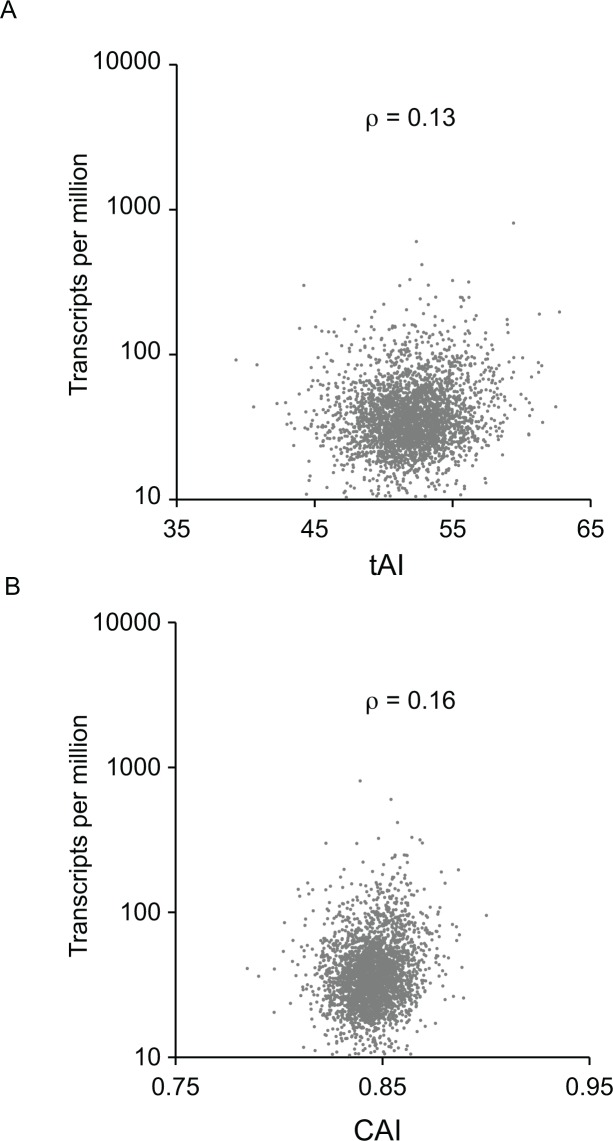
Correlation between (A) tAI score and (B) CAI score for each ORF and the measurement of cognate mRNA abundance for the 5136 single copy, non-developmentally regulated genes in the genome.The Spearman’s rank correlation coefficient was ρ = 0.13 for tAI and ρ = 0.16 for CAI.